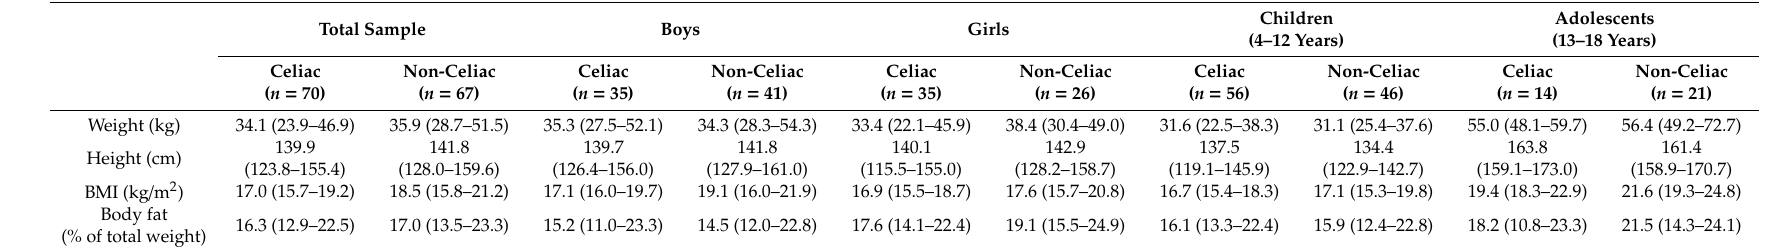
Table 8. Anthropometric characteristics of celiac and non-celiac children and adolescents.